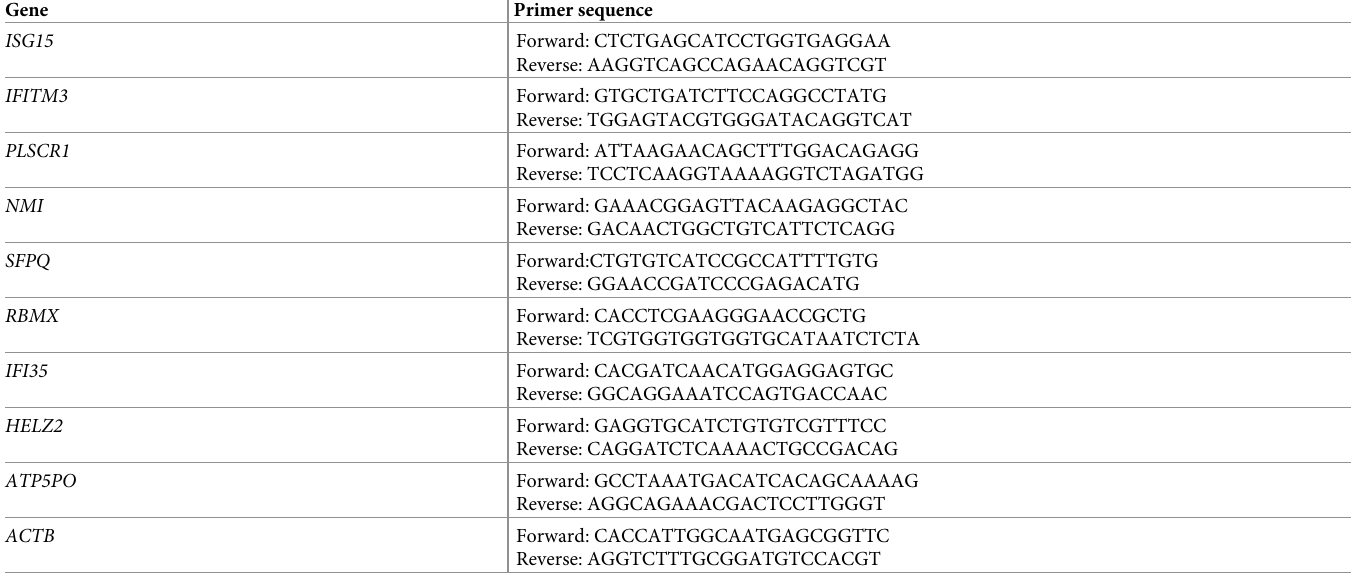
Table 1. List of primers used for qRT-PCR